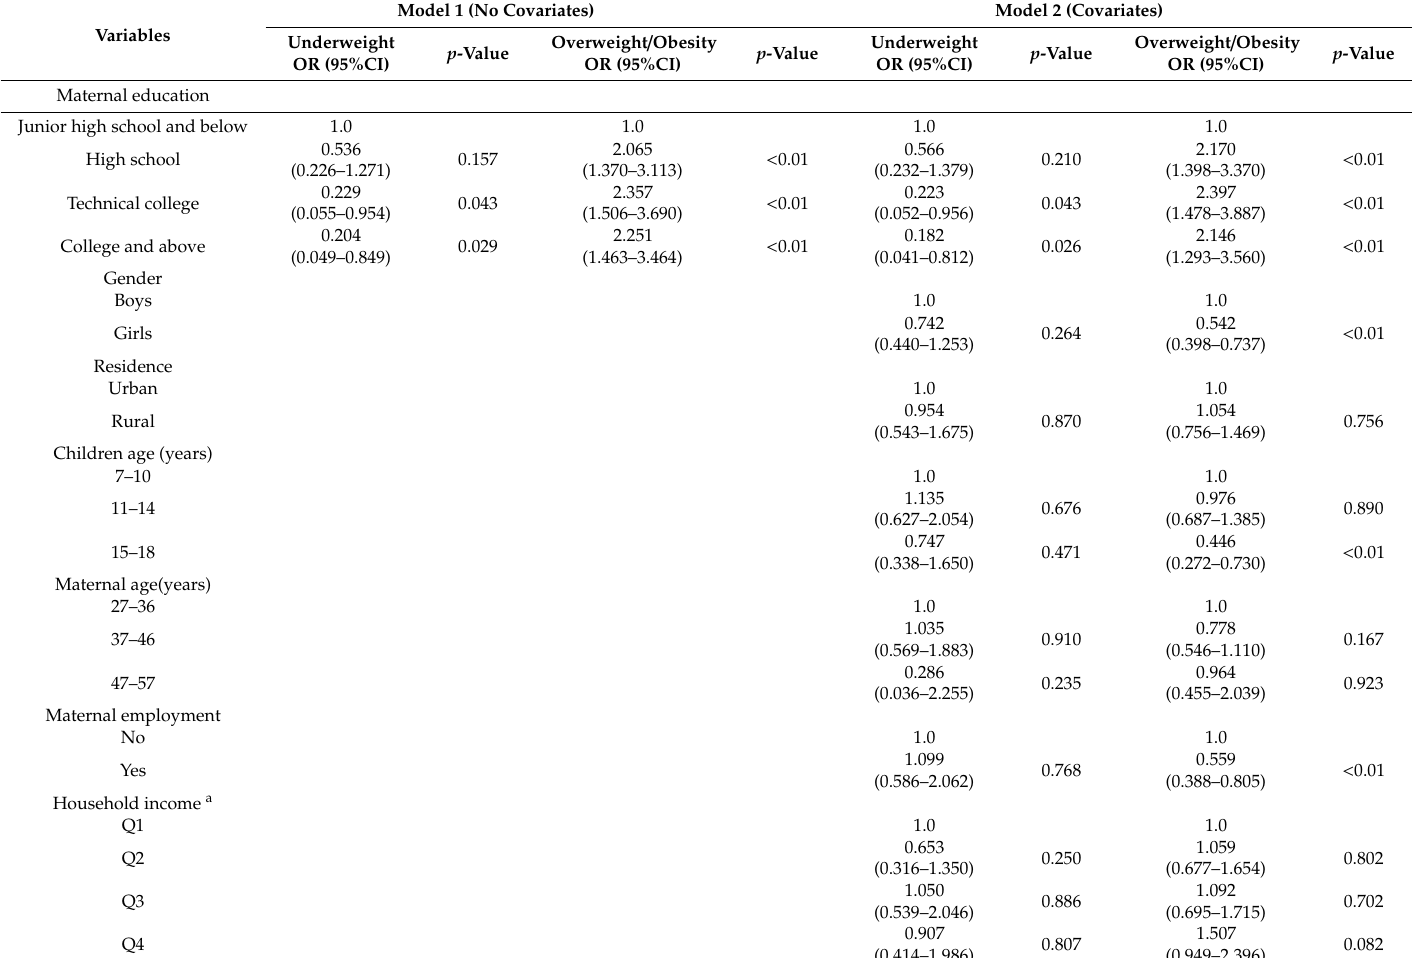
Table 4. Association between maternal education and children’s weight status (Ref. group: